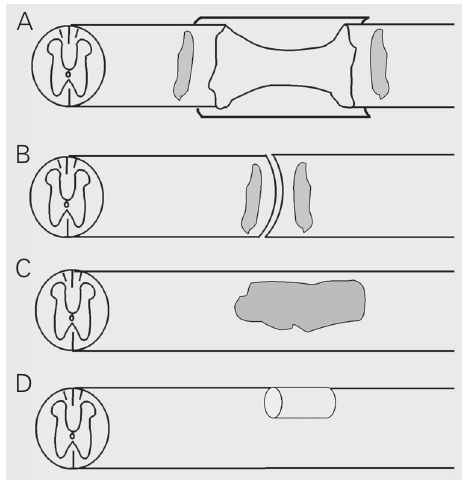
Figure 1. Schematic representation of various spinal cord repair models. In all cords rostral is on the left and dorsal is up. A , Completely transected spinal cord with tissue removed and a Schwann cell cable encased by a polymer tube implanted between the cord stumps. Note that only the back half of the tube is visible and that the cord ends are within the polymer tube (model used in Ref. 16). The dark gray areas close to the rostral and caudal graft-host spinal cord border repre- sent injected olfactory ensheathing glia (model used in Ref. 28). B , Completely transected spinal cord without removal of tissue and with olfactory ensheathing glia (dark gray) implanted in the rostral and caudal cord ends (model used in Ref. 29). C , Contused spinal cord with implantation of cells (darker gray; model used in Refs. 15,19,35,36,40,42). D , Dorsal column transec- tion and implantation of a peripheral nerve bridge as used in Ref.